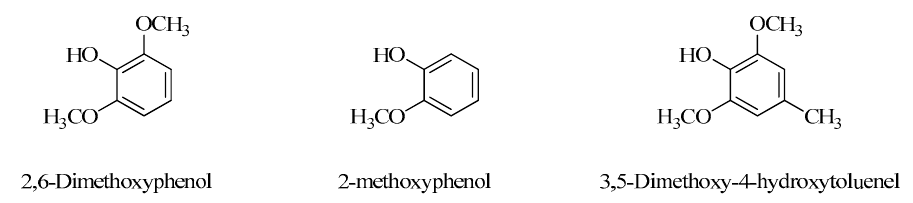
Figure 1. GC-MS analysis of the chemical constituents of the wood vinegar.